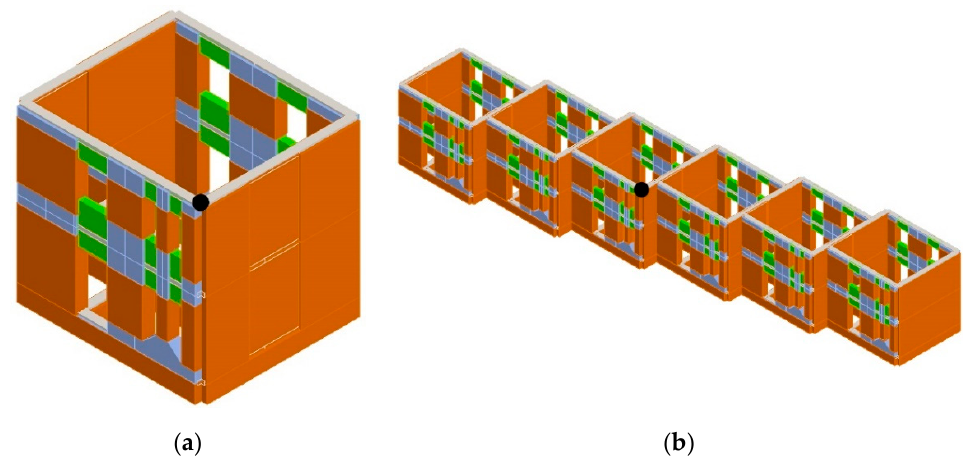
Figure 9. FME model, southeast 3D view: ( a ) single-unit model (unit no. 6); ( b ) whole terrace. Key to colour: piers in orange, spandrels in green, rigid nodes in blue. Black dot indicates control nodes for single-cell and whole terrace analyses, respectively (see Section 3.1.1).